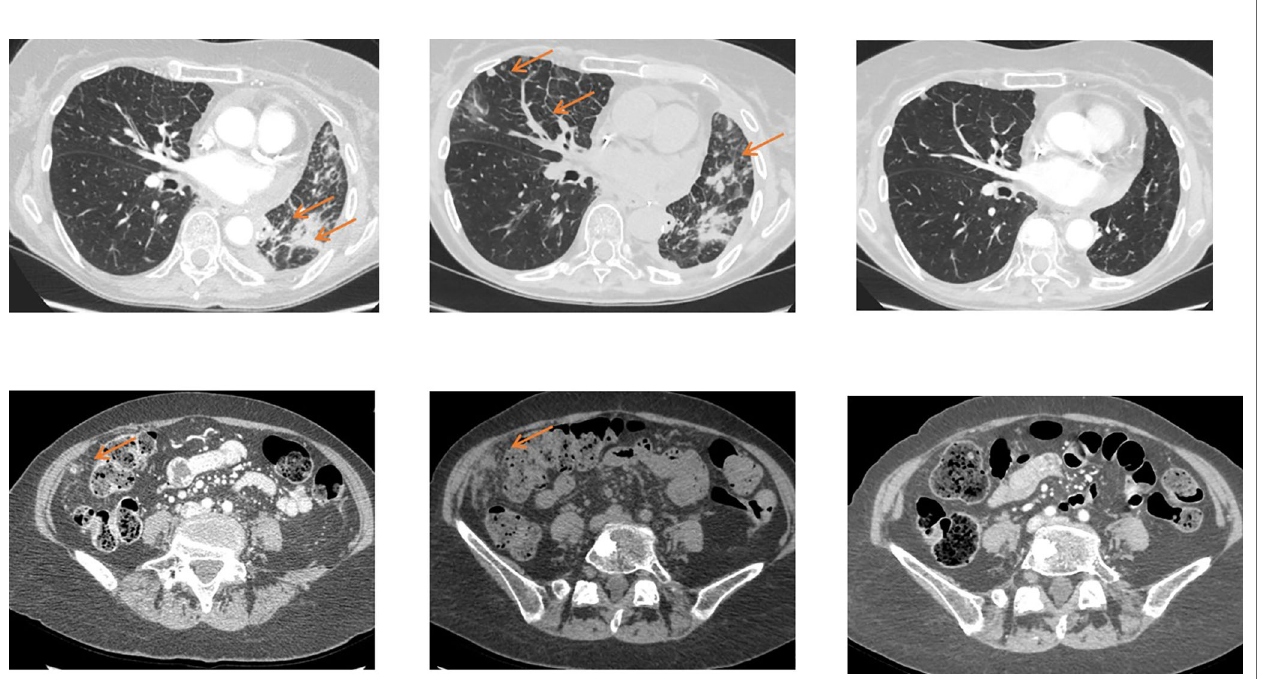
FIGURE 3 | Pseudoprogression on immunotherapy in a 56 yo patient with metastatic non-small cell lung cancer. The baseline image (left) shows lung and peritoneal nodules (arrows). After 4 wks of antiPDL1 therapy (middle), CT shows an increase in previous lesions and the appearance of new lung nodules. Disease was considered immune uncon fi rmed progressive disease. Six weeks later (right) a dramatic response in all previous lesions was seen classifying the patients as a complete responder and endorsing an earlier diagnosis of